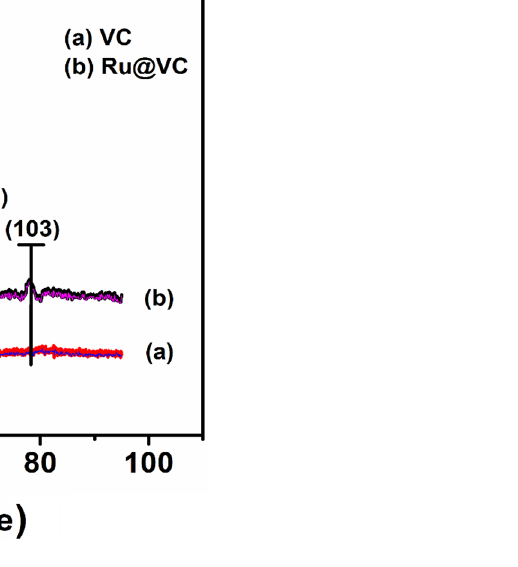
Figure 3. XRD patterns of Ru@VC